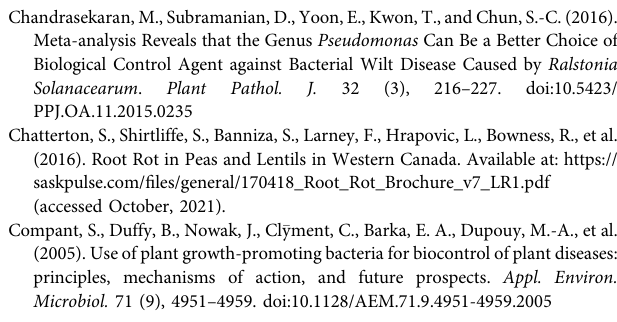
Supplementary Figure S1 | Diagrammatic representation of the steps involved in selecting articles. Supplementary Figure S2 | Application method effect size meta-regression impacting aphanomyces root rot suppression. Error bars indicate con fi dence interval ( p < .05). Number of studies: Amendment 35; Seedcoat 79; and Suspension 45. Supplementary Figure S3 | Study type effect size meta-regression impacting aphanomyces root rot suppression. Error bars indicate con fi dence interval ( p < .05). Number of studies: Field trial 41, Growth chamber 101 and Lab assay